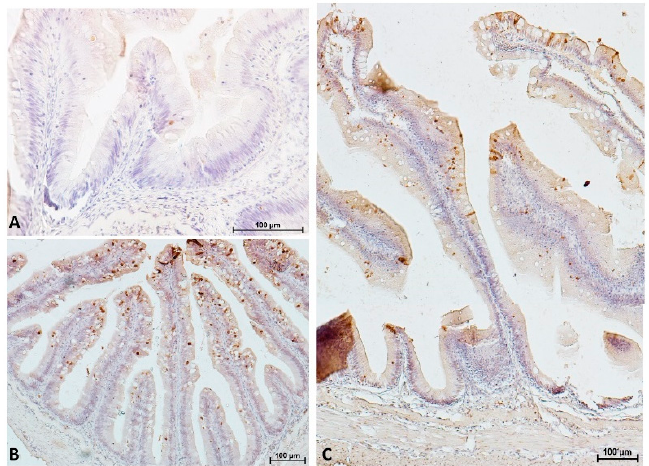
Figure 16. Representative figure of cells undergoing apoptosis showing only a few round apoptotic cells in the anterior tract ( A ) and many more apoptotic cells, both round and slender in the pyloric caeca ( B ) and in the posterior intestine ( C ).